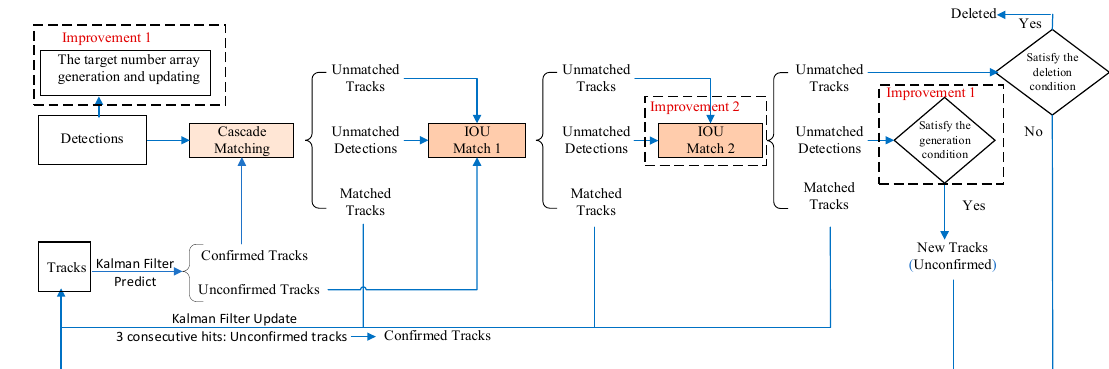
Figure 4. Flow chart of the tracking process of the improved DeepSORT.